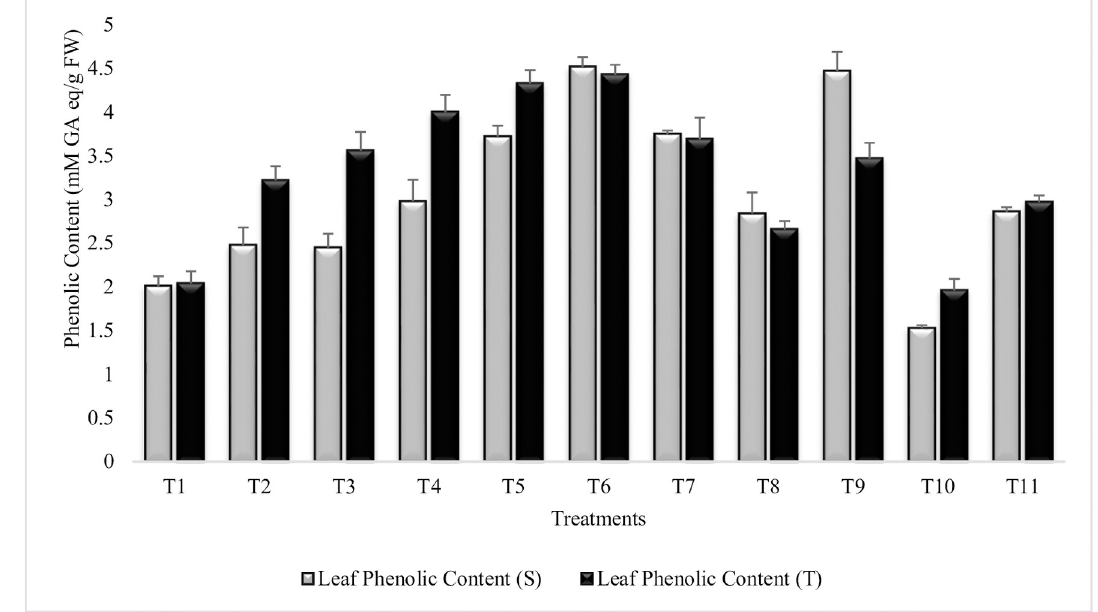
Fig 5. Leaf phenolic content of chickpea grown in sandy soil. Data are means of four replicates along with standard error bar (S-Sensitive Variety; T-Tolerant Variety).